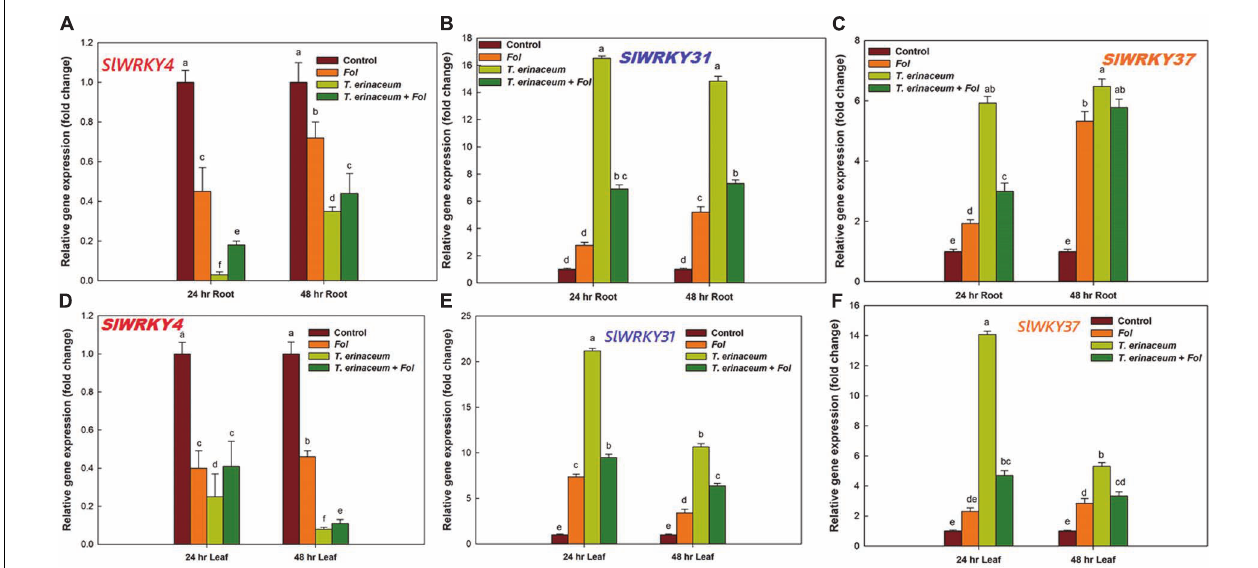
FIGURE 4 | Quantitative PCR results showing the tissue specific and time bound differential expression of tomato WRKY genes in all the four defined conditions measured at different time intervals (0, 24, and 48 h). (A) The quantitative expression of SlWRKY4 gene in root tissues data showing the relative change in expression values (fold change). (B) The relative fold change in expression value for SlWRKY31 (previously named as SlWRKY33A ; SlDRW1) expressed in tomato roots. (C) The relative fold change in expression value for SlWRKY37 gene expressed in root tissues. (D) Relative fold change in expression values for SlWRKY4 expressed in tomato leaves. (E) The expression data for SlWRKY31 in leaves. (F) The expression data for SlWRKY37 in leaf tissues. The SlWRKY4 genes were found to be downregulated in both root and leaf tissues. Bars with distinct alphabetical letters are significantly different at P ≤ 0.05 applying the DMRT